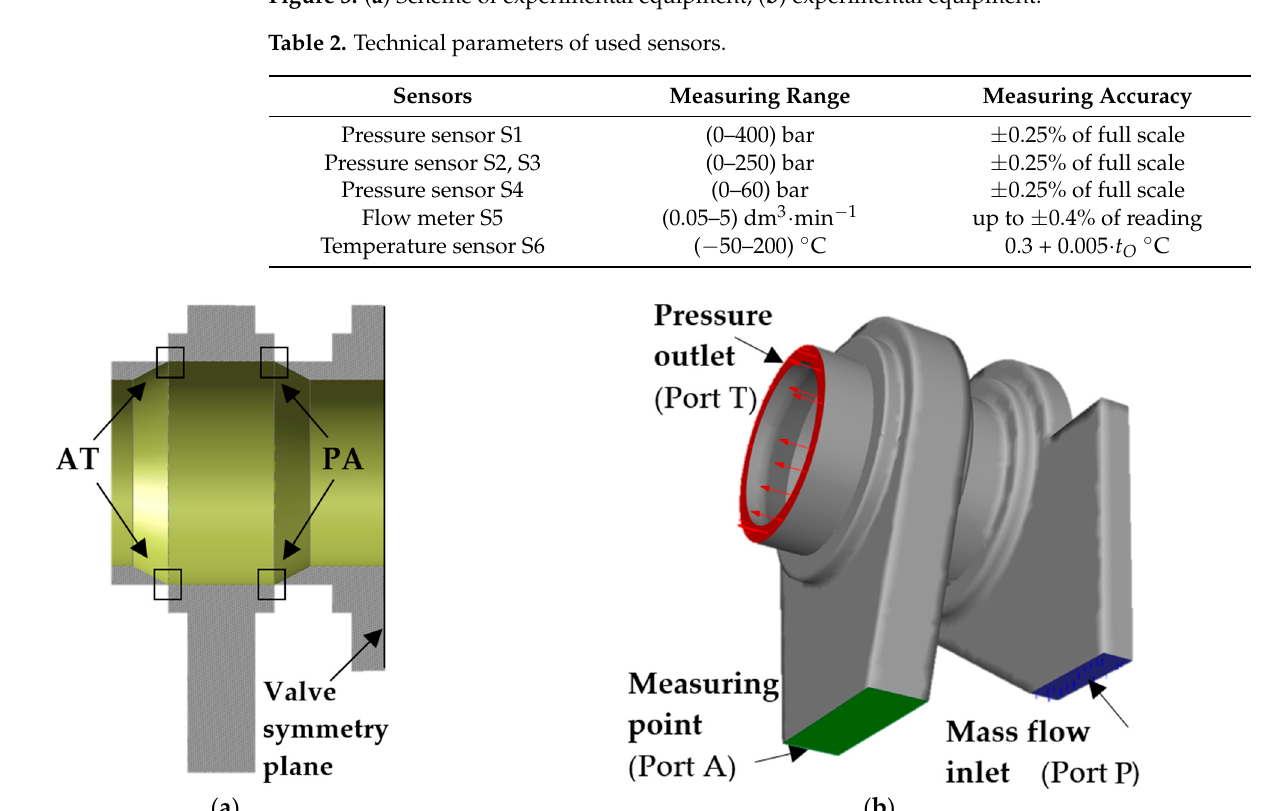
Figure 4. ( a ) Section of modelled area for load port A, ( b ) boundary